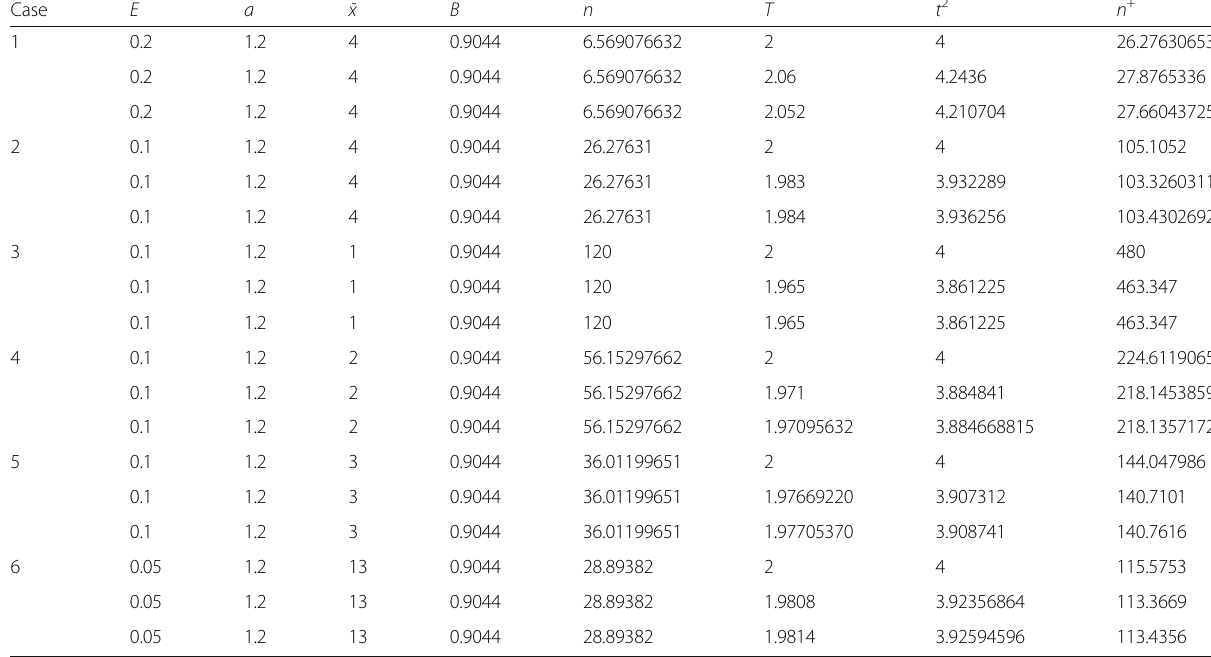
Table 2 Exact figures from Microsoft Excel Worksheet used to calculate the sample size before (Student ’ s t = 2) and after iteration for heterorhabditid nematode-infected Galleria mellonella larvae